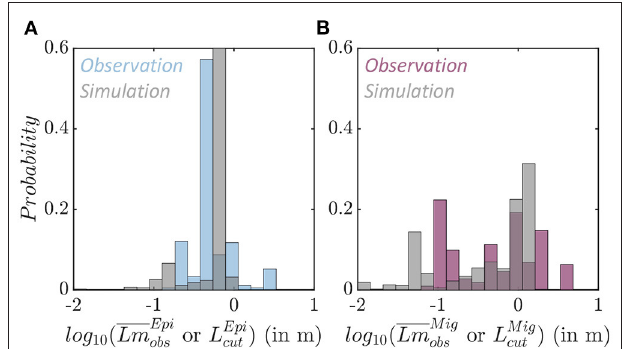
FIGURE 8 | Biomass size spectra. (A) Envelop for the simulated normalized biomass size-spectra (dotted line) and observed biomass size-spectra (solid line), in a coastal (light blue) and an offshore (dark blue) cell. (B) Slopes λ Epi of the local average size-spectra for the epipelagic community. (C) Slopes λ Mig of the local average size-spectra for the migratory community. In (A) , the black line shows the expected theoretical slope of λ = − 1. In (B,C) , the light/dark blue dots indicate the cells where coastal/offshore biomass spectra (A) come